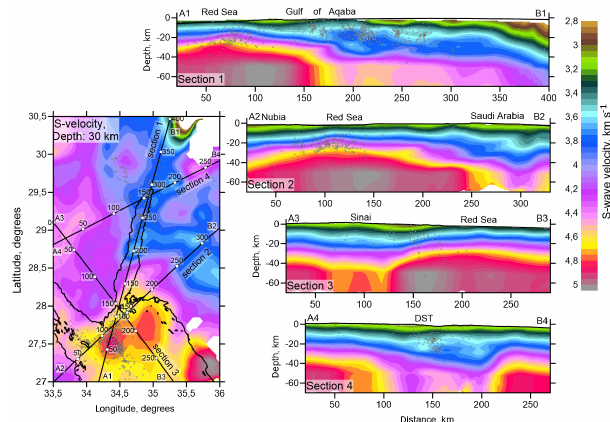
Figure 9. Same as Fig. 8, but for the S absolute